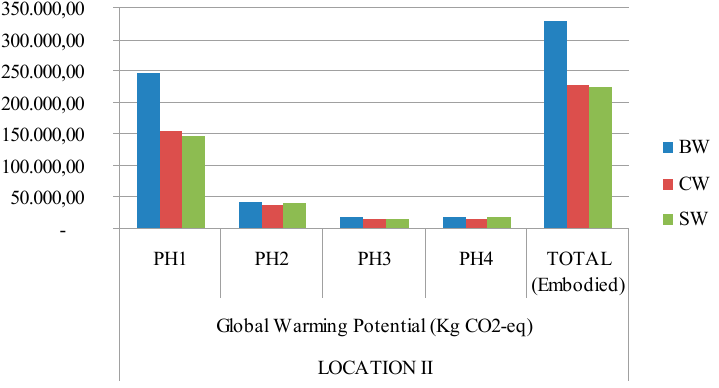
Figure 4. GWP 100a (Kg eq-CO 2 ) for each type of building construction system and continental climate (location 2). PH1: manufacturing; PH2: constructing−demolishing; PH3: transport; PH4: final disposal. BW: ceramic brick walls; CB: concrete block walls; SW: stabilized soil walls.